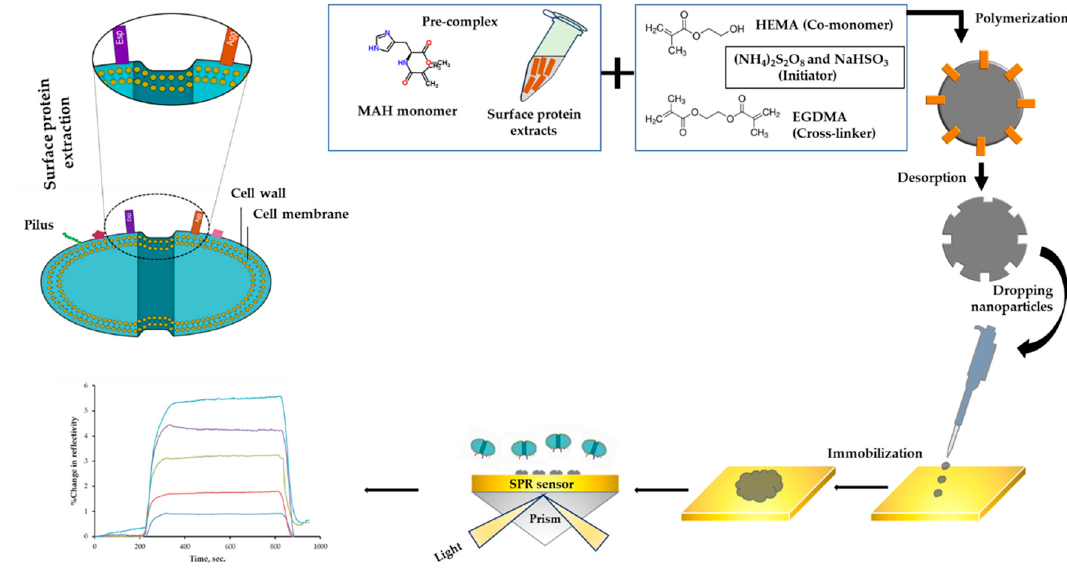
Figure 1. Scheme of nanoparticle and sensor preparation.